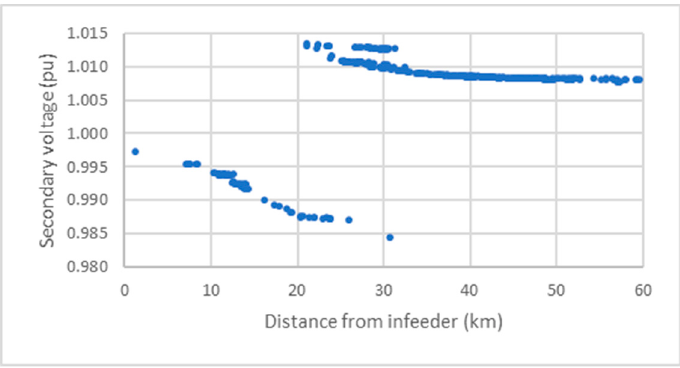
Figure 12. Secondary terminal voltage profile for MV/LV transformers for Case 2.1. Energies 2020 , 13 , x FOR PEER REVIEW